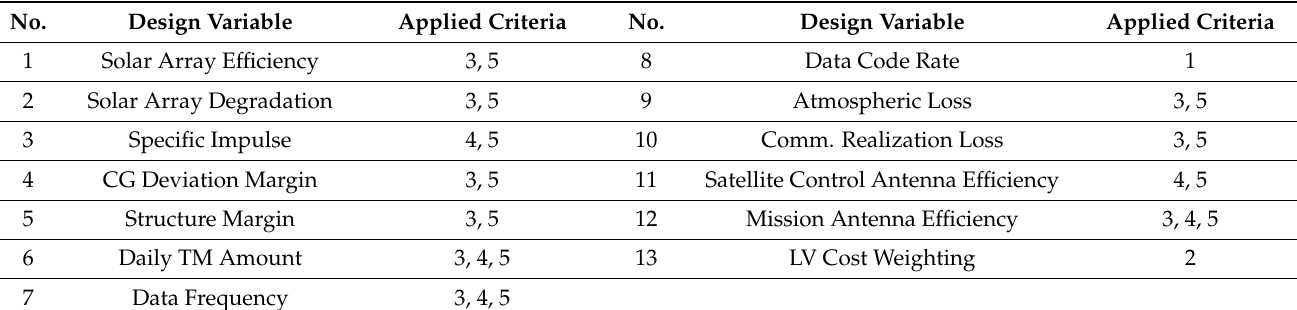
Table 10. Screened design